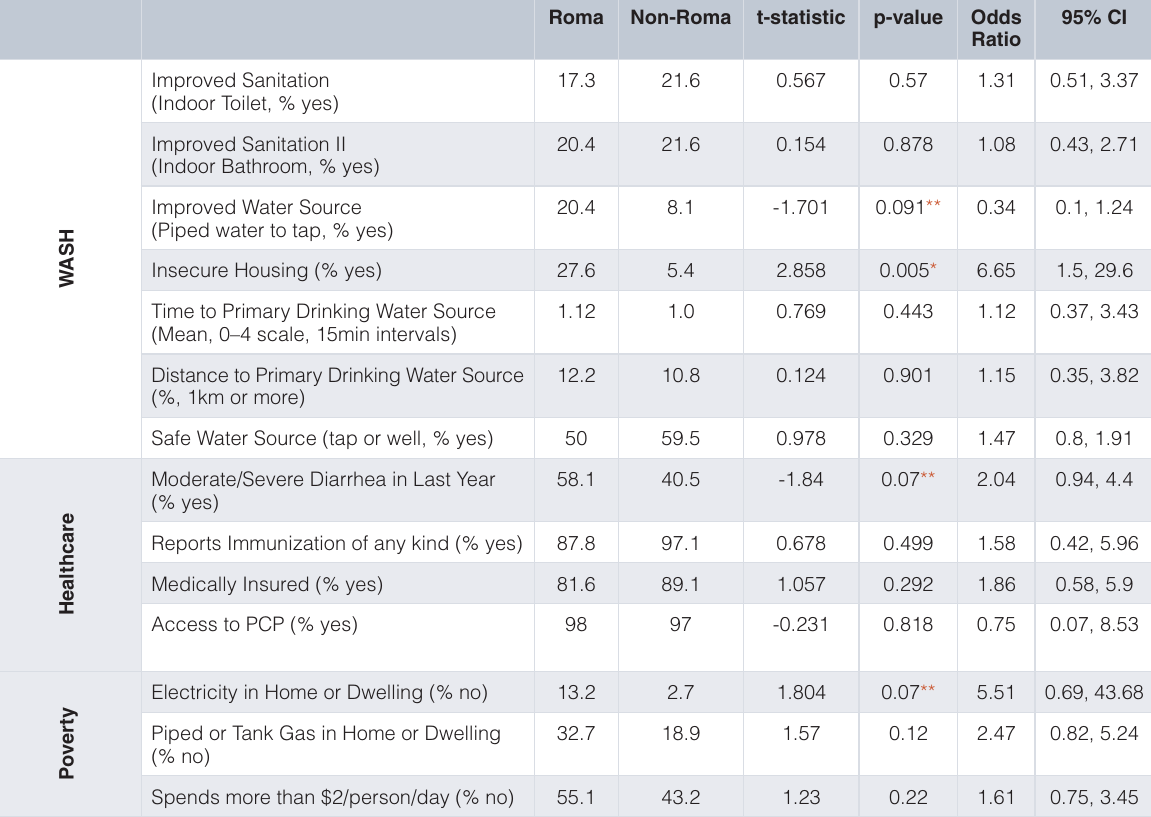
Table 2. Univariate analyses. Romania, 2016. Reference population for all variables is non-Roma. * indicates significance at 95% CI level. ** indicates significance at 90% CI level. Roma Non-Roma